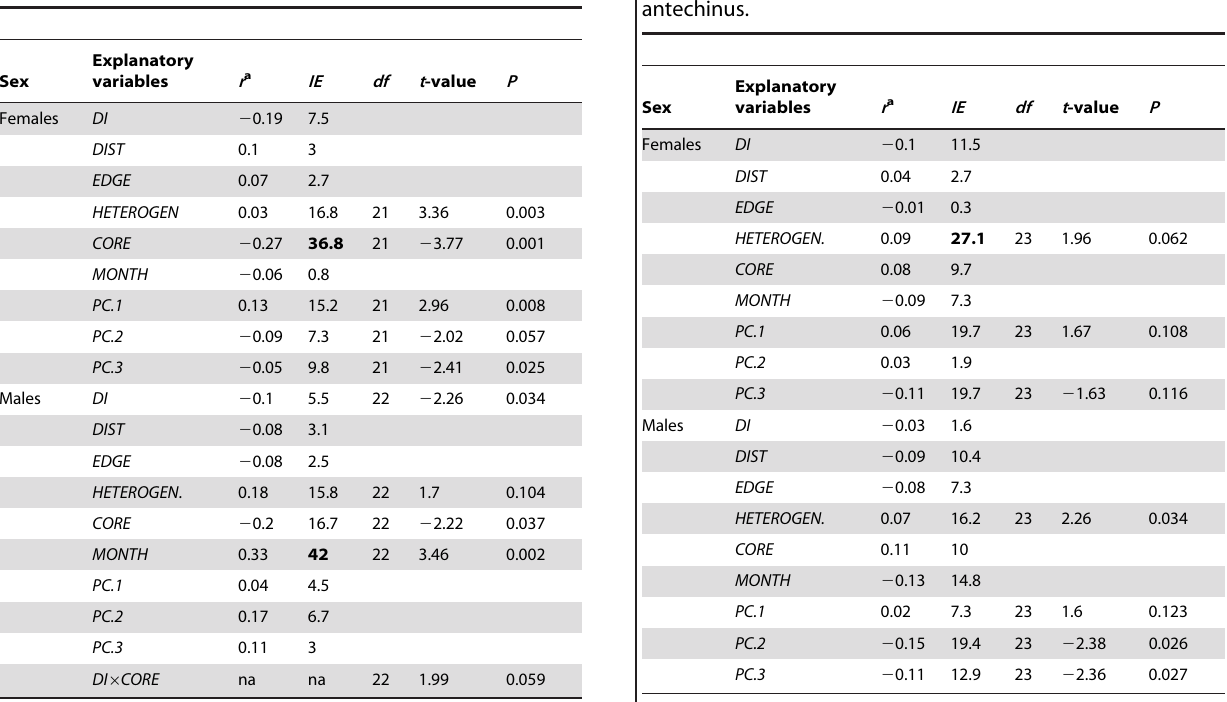
Table 7. Relationships between mass-size residuals (MSR) (g) and environmental variables for agile antechinus.